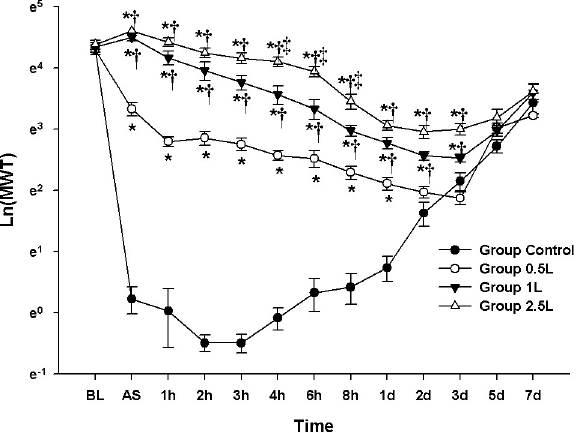
Fig 2. Evaluation of analgesic effect according to dose of lidocaine: Lidocaine dose response test. The graphs are presented as means ( ± standard error of the mean) of the log-transformed mechanical withdrawal threshold with von Frey filaments. BL: baseline, AS: after surgery. � P < 0.05 compared with Group Control, † P < 0.05 compared with Group Lidocaine 0.5% + Fixed BMI, ‡ P < 0.05 compared with Group Lidocaine 1%+ Fixed BMI.